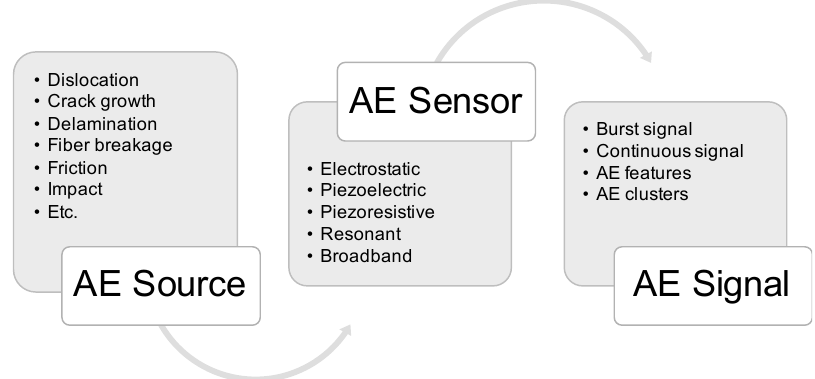
Figure 1. The simplified chain of acoustic emission (AE) sensing—AE sensor bridging AE source and AE signal.